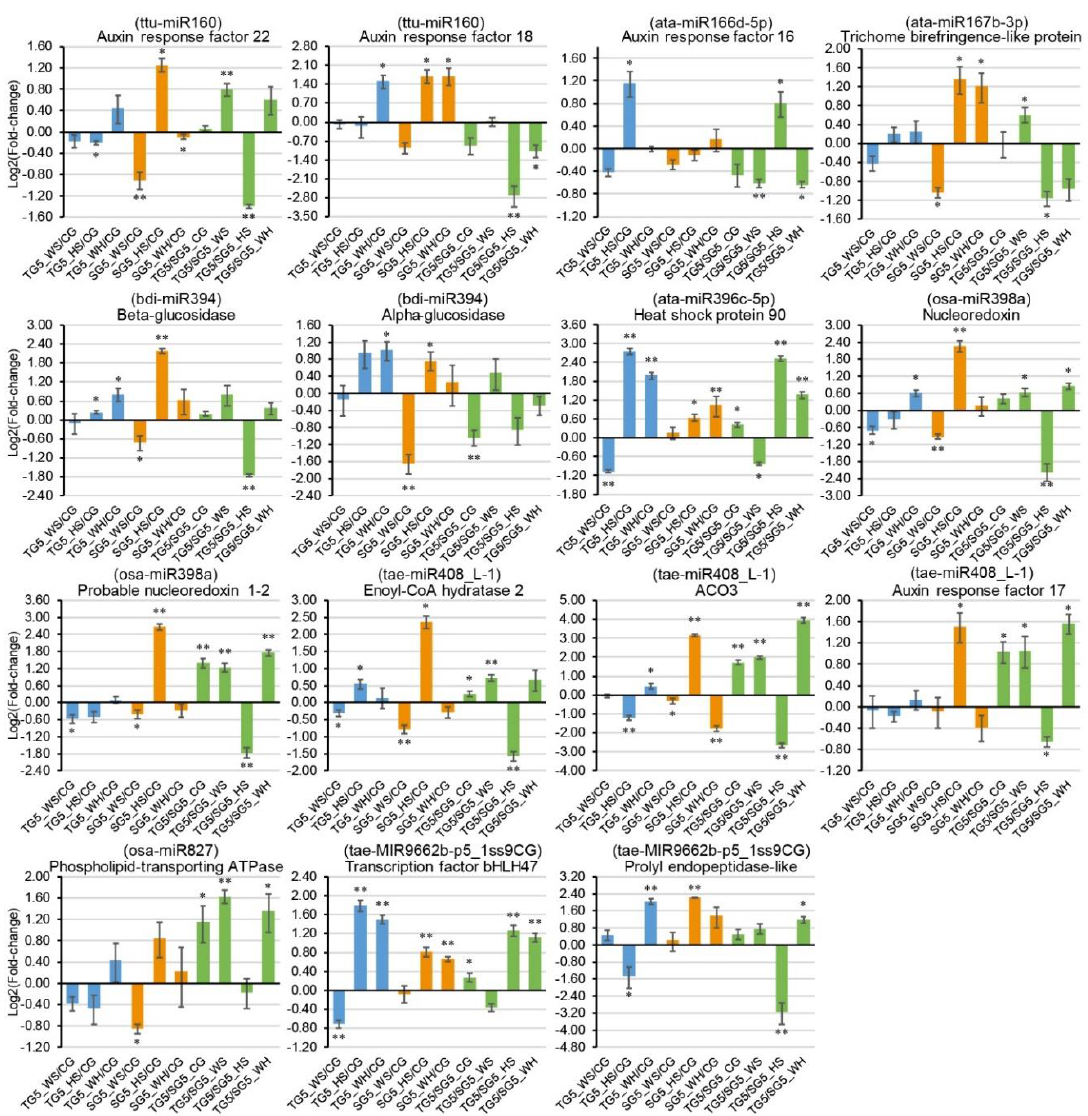
Figure 6. qPCR analysis of 15 stress-responsive target genes at 5 DPA (days post anthesis). The 2 −ΔΔCt method was used to calculate relative gene expression using GAPDH as the housekeeping gene. Each expression profile is shown as the log 2 value of the fold-change, and the fold-change was calculated as follows: (relative gene expression level under stress condition)/(relative gene expression level under the control condition) or (relative gene expression level in DBA Aurora)/(relative gene expression level in L6). Data are represented as the mean ± SE (three replicates). * p < 0.05, ** p < 0.01. Abbreviations: ACO3 (1-aminocyclopropane-1-carboxylate oxidase